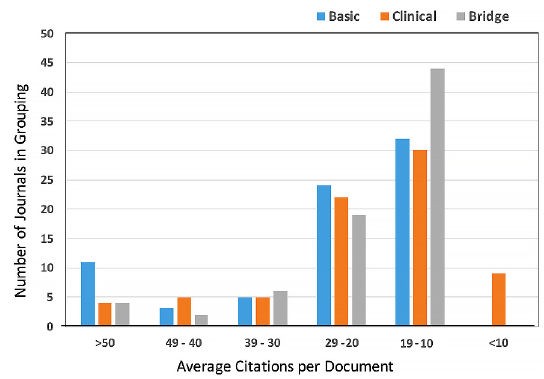
Figure 3. Distribution of citations per document for the three categories.